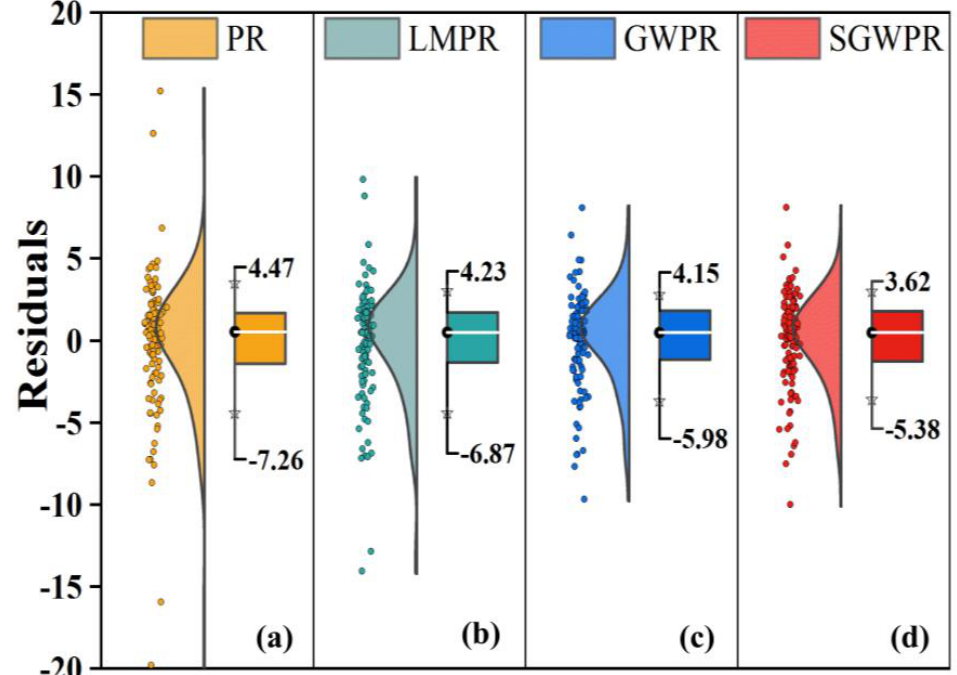
Figure 3. Residual boxplots of the four assessed models: global (( a ) PR represents the Poisson regression and ( b ) LMPR represents the Liner mixed PR) models and local (( c ) GWPR represents the Geographically weighted PR and ( d ) SGWPR represents the semiparametric GWPR) models.